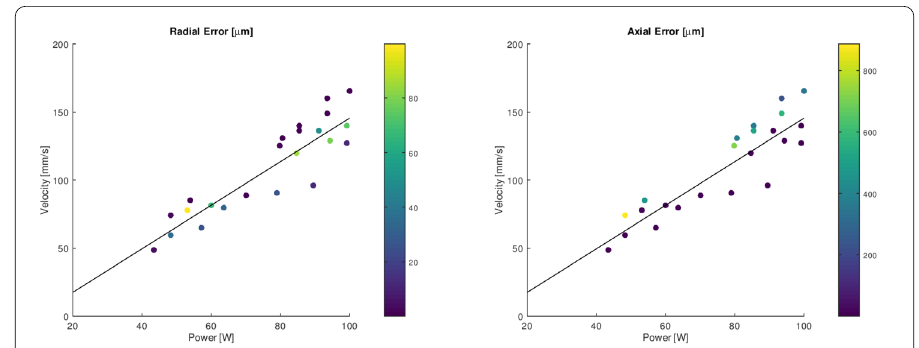
Figure 15 Case Study 2: Radial Error ( left ) and Axial Error ( right ) of Final Pareto Solutions with s ≥ 2.8 mm. The color of each dot indicates the radial and axial error, respectively. Solid line corresponds to v opt